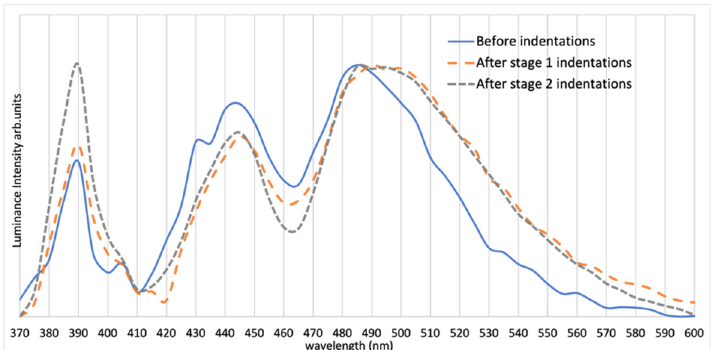
Figure 3. Spectra of Sample 1 before indentations and after Stages 1 and 2 of indentations. Note the change in the spectrum particularly after Stage 1 of indentations (spectra are normalized at the maximum value). All sample were connected to a DC power supply with 0.2 A current flow.